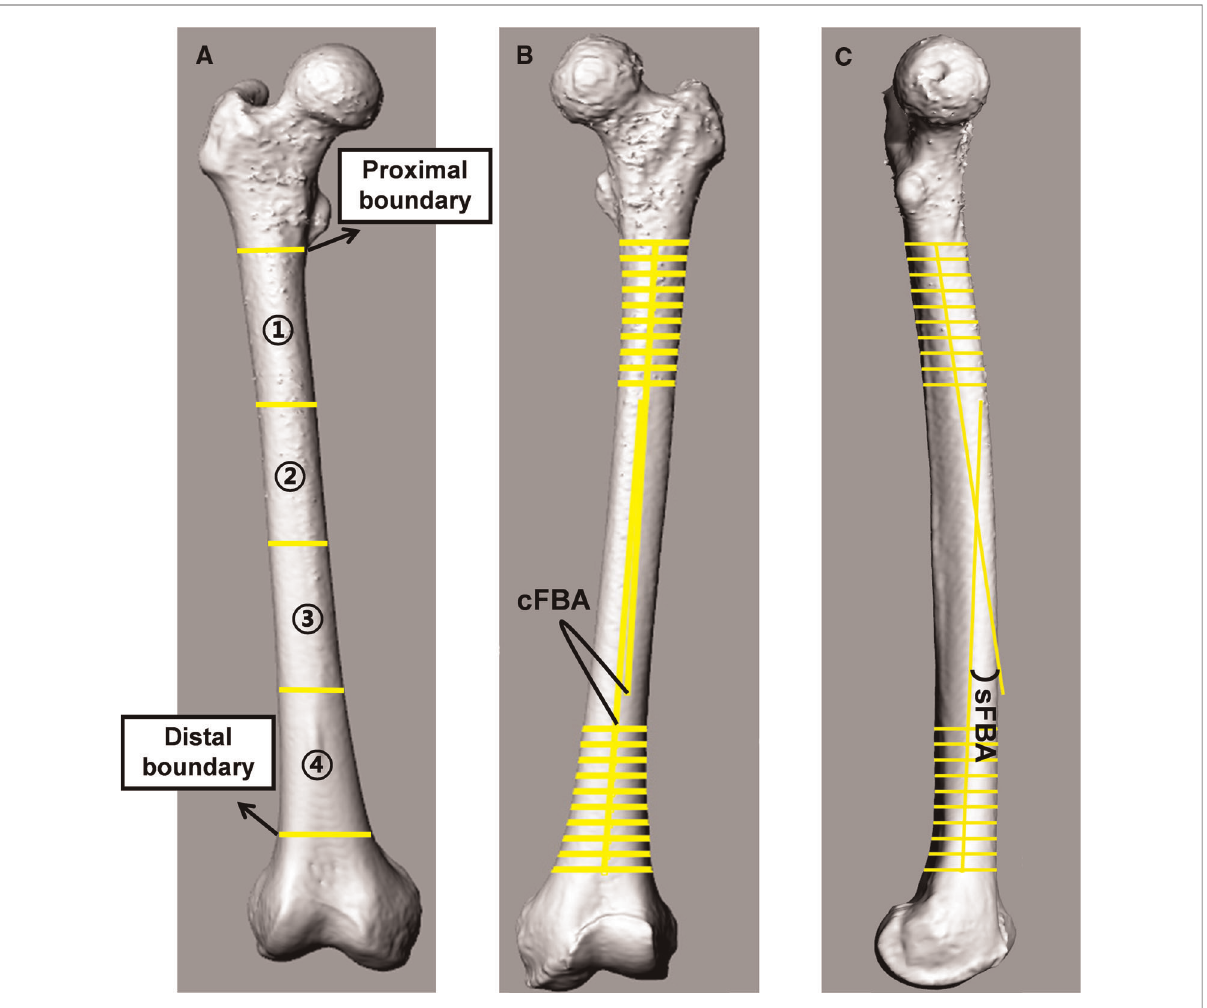
FIGURE 2 Femoral bowing in coronal and sagittal planes. ( A ) The femoral shaft was divided into four equal parts in the space. The proximal border was the lower edge of the lesser trochanter, and the distal border was the juncture between the femoral shaft and condylar region. ( B,C ) The angle between two midlines fi tted by the points of 10 isometric cross-sections of proximal and distal femoral shaft sections was de fi ned as the coronal femoral bowing angle (cFBA) in the coronal plane and the sagittal femoral bowing angle (sFBA) in the sagittal